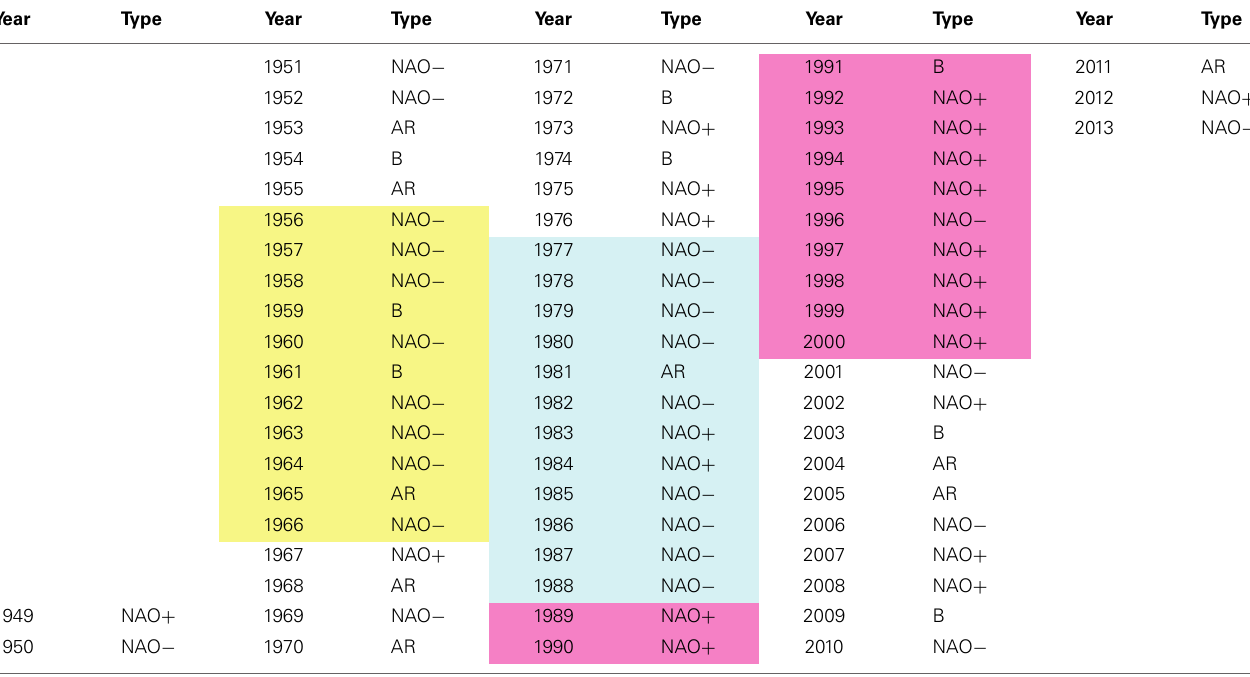
Table 1 | Composite analysis of sea-level pressure (SLP) anomalies during winter (December–March) according to the classification given by Hurrell and Deser (2009).